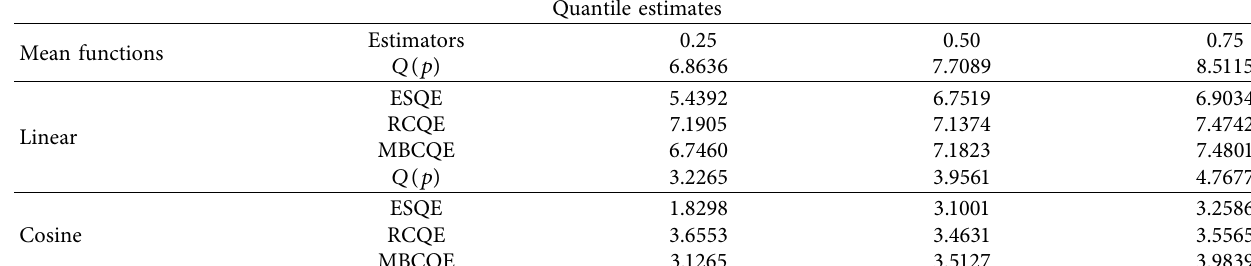
Table 2: Comparison of empirical quantile estimator with other estimators.